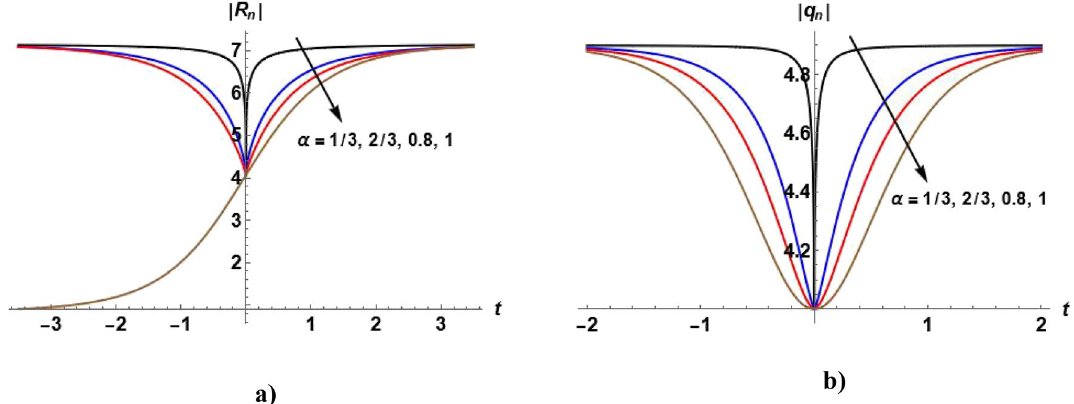
c c c c c 2 = 1, 4 = 3 = 0, 6 = 4 , β = 0.5 and odd 5 = 2, =